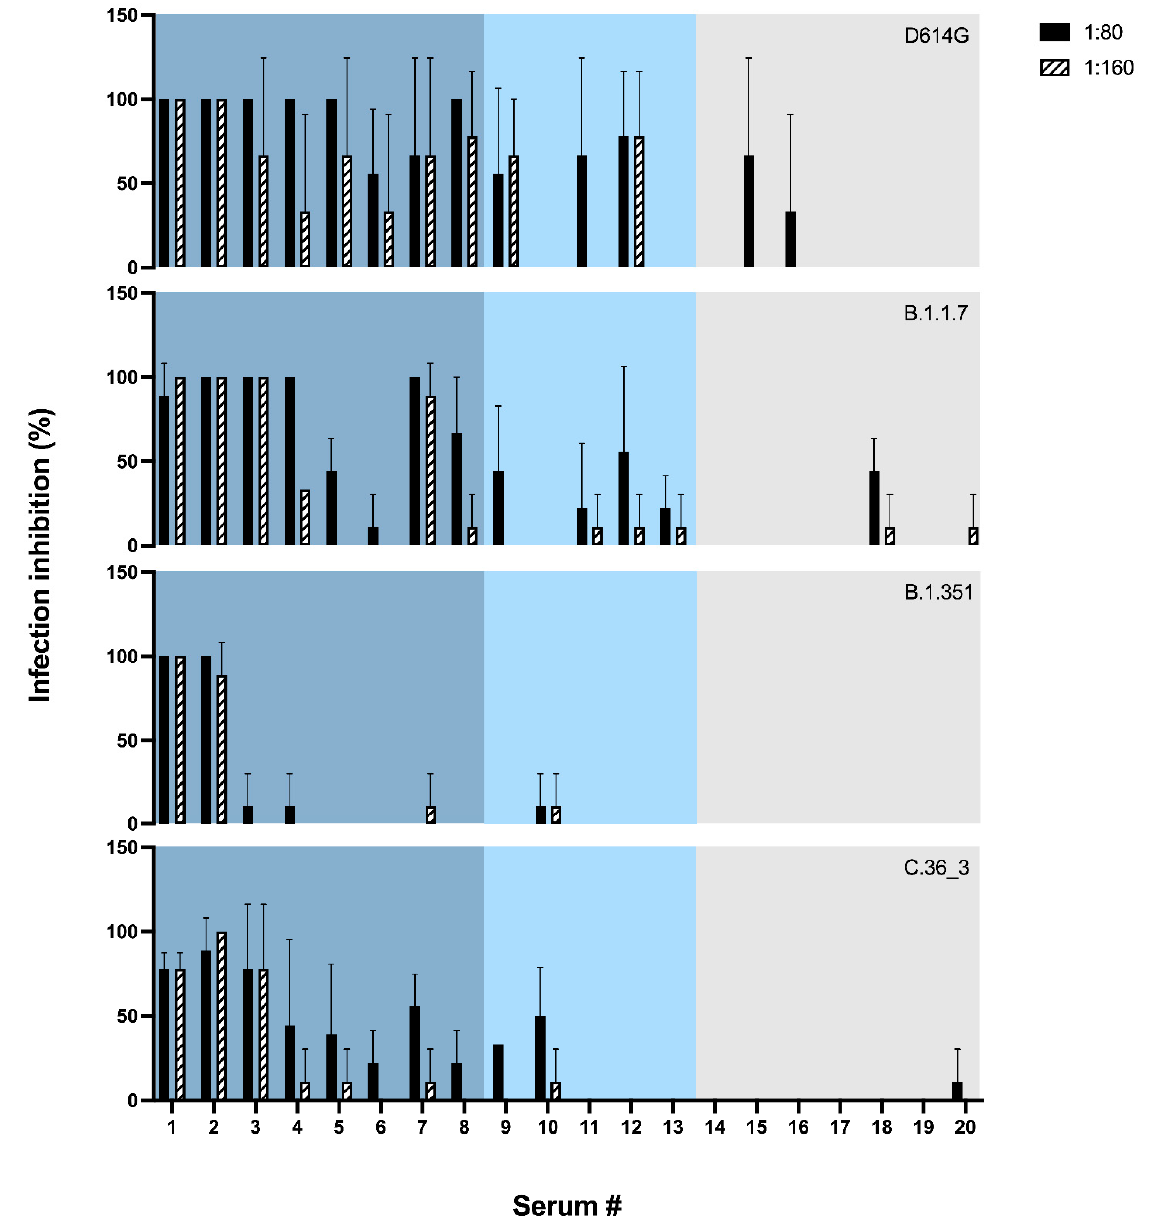
Figure 2. Neutralization assay. Neutralizing activity was assessed using two sera dilutions (1:80 and 1:160) against 0.01 MOI of four SARS-CoV-2 variants: D614G (black), B.1.1.7 (blue), B.1.351 (orange), C.36 (green). Mean values + SD are reported, each condition was tested in triplicate. Sera are ordered according to the anti-RBD titer and reported in blue, light blue and grey for titer >2500 U/mL, 2500–1000 U/mL or <1000 U/mL, respectively. In conclusion, at the two tested sera dilutions, strain hCoV-19/Italy/LOM-UnINSU/2021 We further characterized in silico the C.36_3 Spike in terms of its RBD affinity for showed a reduced sensitivity profile the closest to VOC B.1.351 (Figure ACE2 and its ectodomain dynamics. Affinity calculations did not show any obvious